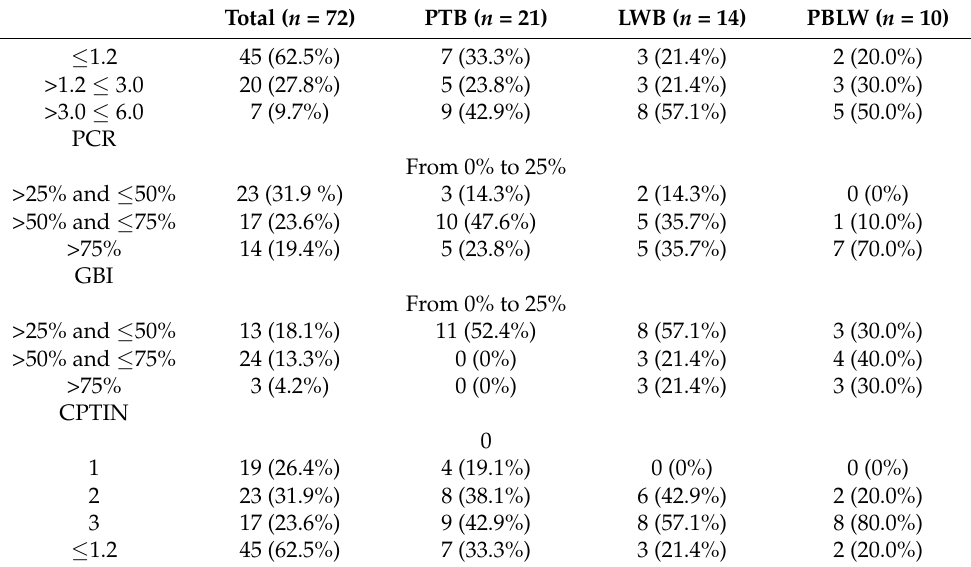
Table 2. Oral hygiene status in pregnant women included in this study ( n =